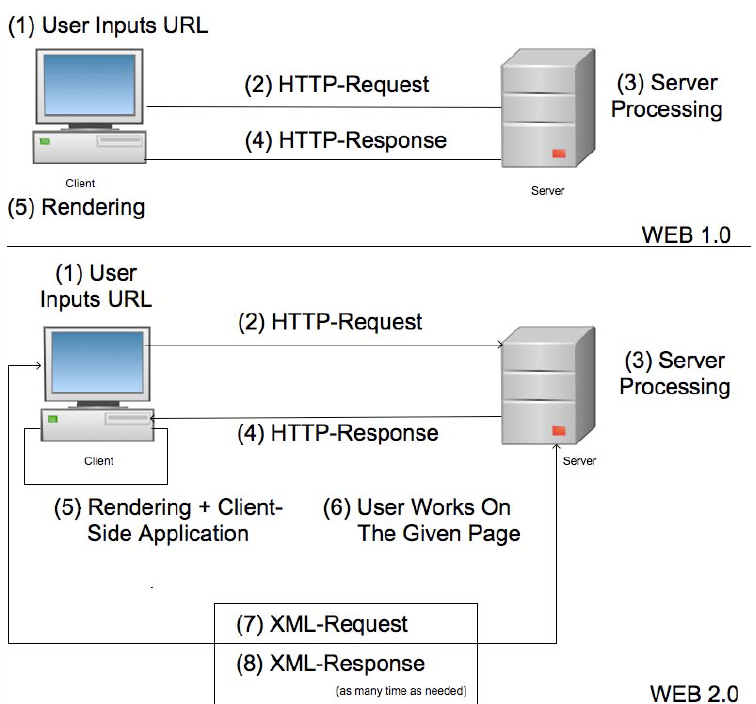
Figure 2. WEB 1.0 versus Web 2.0, one way communication